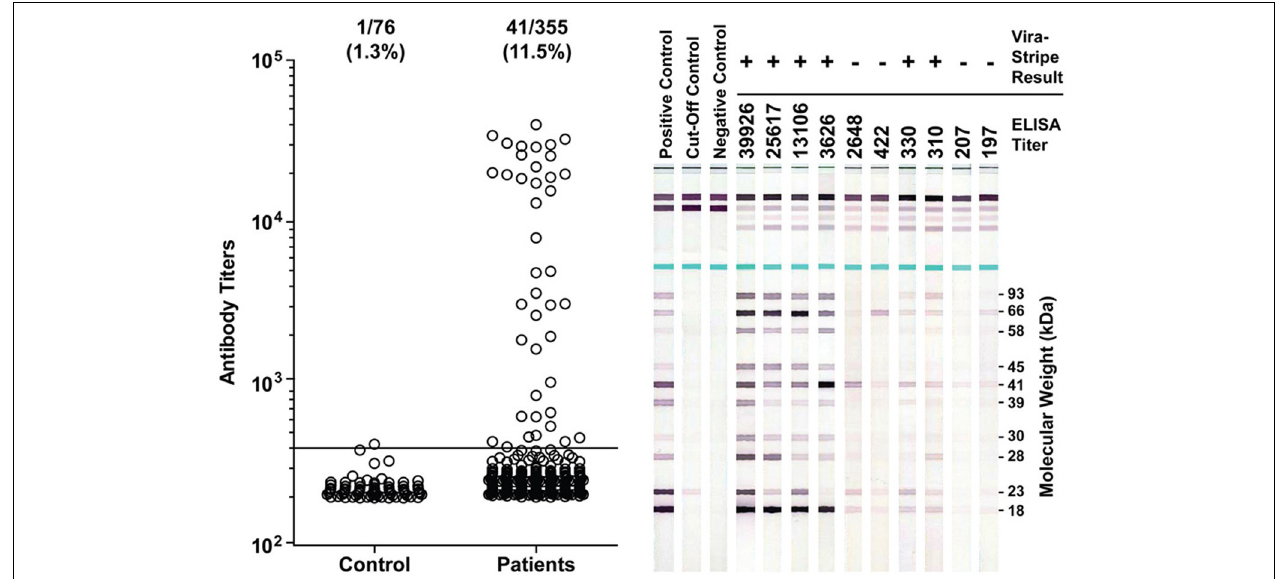
FIGURE 5 | Detection of antibodies to B. burgdoferi antigens in Ohio dogs. Antibody titers as determined by ELISA are plotted in the left graph. The ratio and percentage of samples tested positive (titer > 400) were shown above the graph for each group. The serum samples from 76 healthy greyhound blood donors were included as a